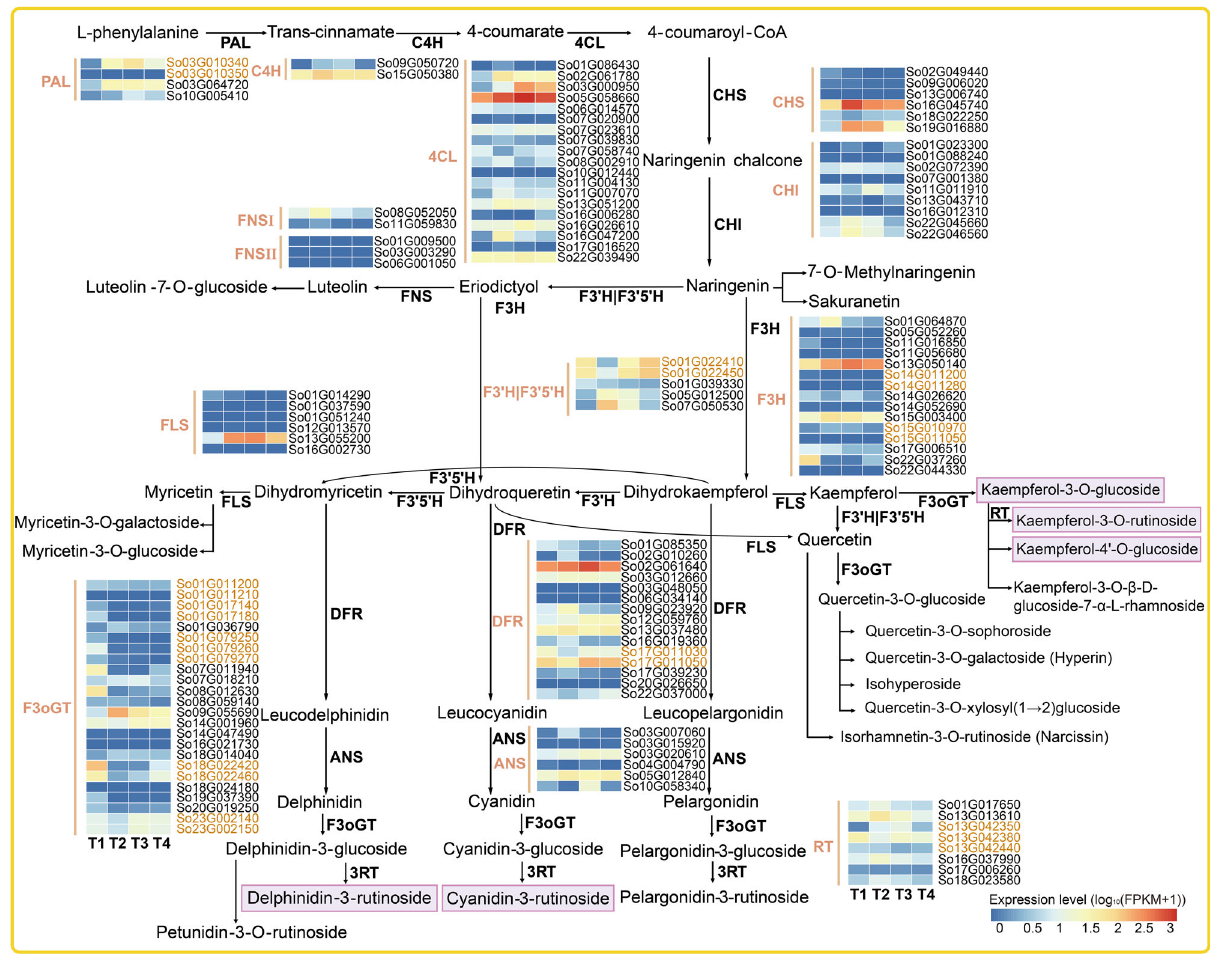
Fig. 3 The metabolic pathways and metabolic composition of fl avonoids in S . oblata . The metabolic pathways of fl avonol and anthocyanin. Gene expression pro fi les (log 10 (FPKM + 1)) at different fl ower opening stages (from left to right were T1-T4), and the bar color change from blue to red indicates the expression from low to high. The left side of the heat map was the corresponding enzymes, and the right was the genes id within the genome. Genes identi fi ed in tandem clusters were marked in yellow color, and the top5 metabolites of petals at the four periods were marked with purple box. PAL phenylalanine ammonia-lyase, C4H cinnamate-4-hydroxylase, 4CL 4-coumarate CoA ligase 4, CHS chalcone synthase, CHI chalcone isomerase, F3H fl avanone 3-hydroxylase, F3'H fl avonoid 3'-hydroxylase, F3'5'H fl avonoid 3'5'-hydroxylase, FLS fl avonol synthase, DFR dihydro fl avonol 4-reductase, ANS anthocyanidin synthase, F3oGT fl avonoide-3-O-glucosyltransferase, RT